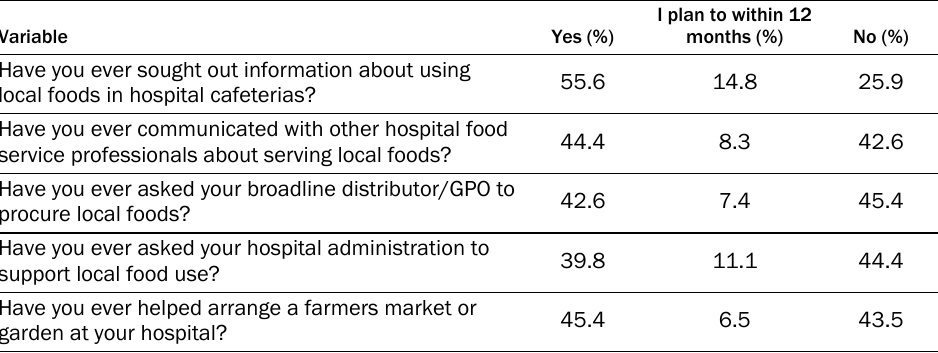
Table 3. Potential Interest and Action Around Local Food Variable